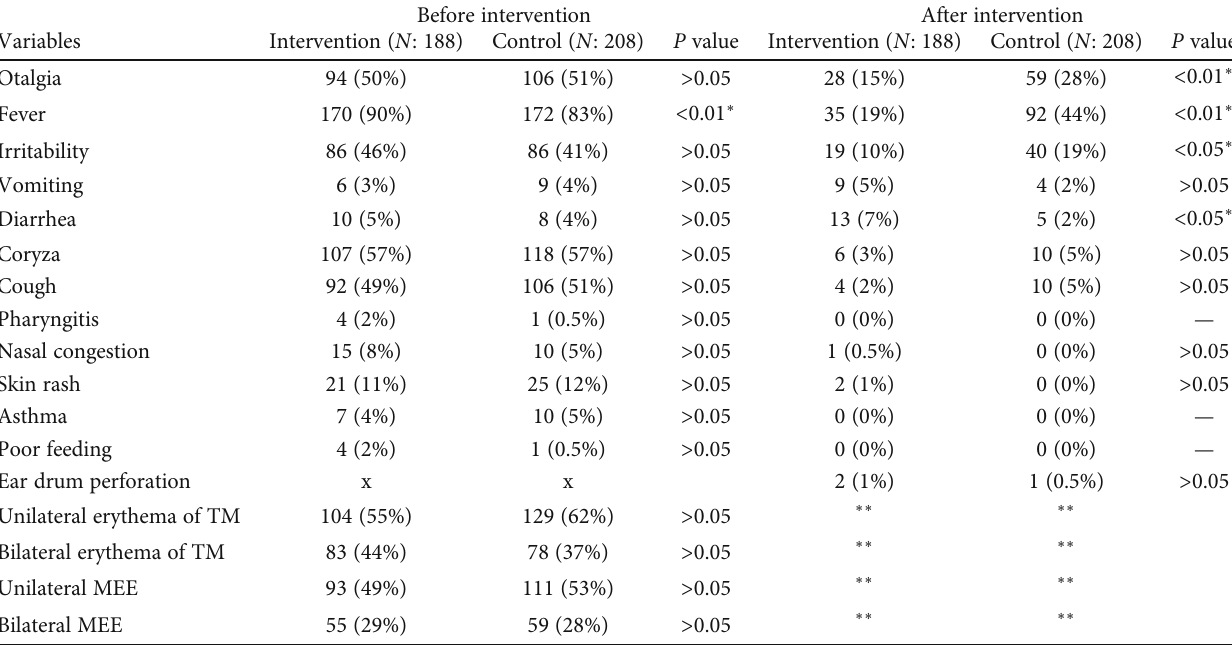
Table 2: Clinical symptoms of the patients before and after intervention. Before intervention After